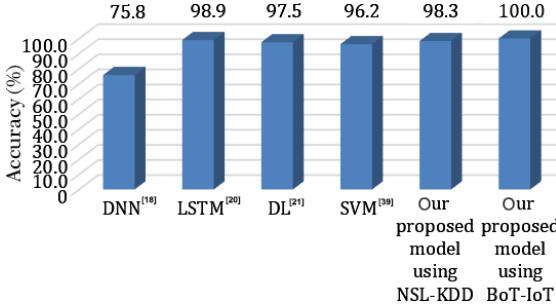
Fig. 8 Performance comparison between the proposed model and other